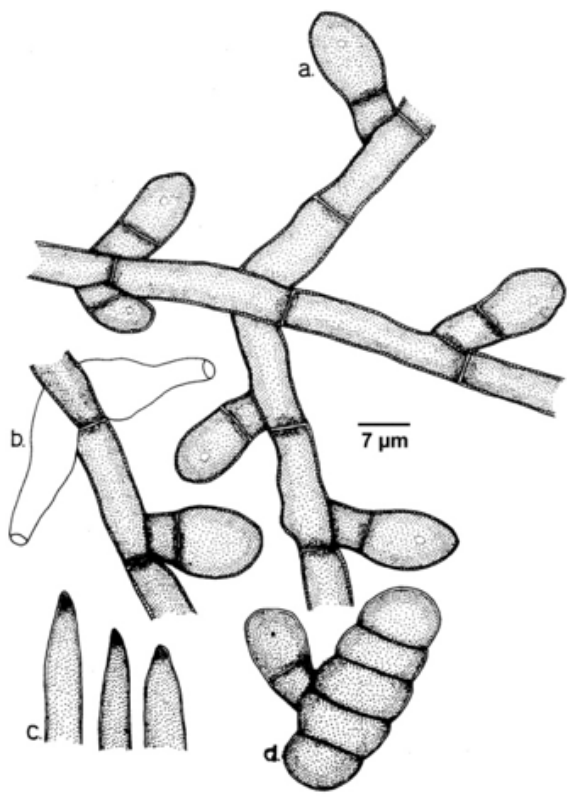
Figure 120. Meliola tamarindi a - Appressorium; b - Phialide; c - Apical portion of mycelial setae; d - Ascospores